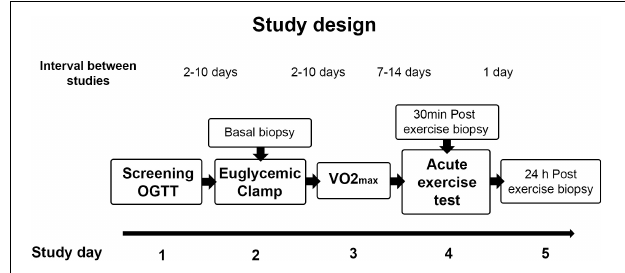
FIGURE 1 | Study design. Participants were screened for inclusion criteria and an oral glucose tolerance test (OGTT) was performed. After completion of screening studies, participants performed a VO 2 max test and a single bout of exercise, and insulin sensitivity was assessed by an euglycemic clamp. Muscle biopsies were taken at rest before the glucose clamp and 30 min and 24 h after completion of the single exercise